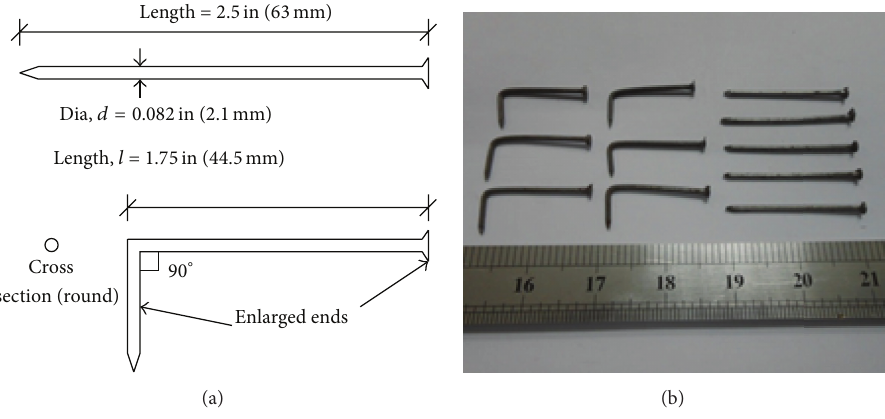
Figure 3: ((a) and (b)) Size and geometry of the customized enlarged ends steel fibers employed in this